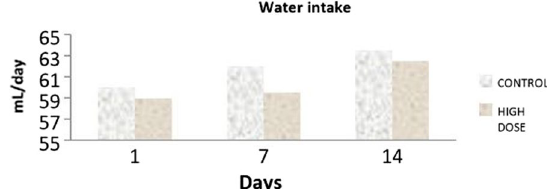
Fig. 3 Change in water intake (mL/day) of the animals exposed to TRV